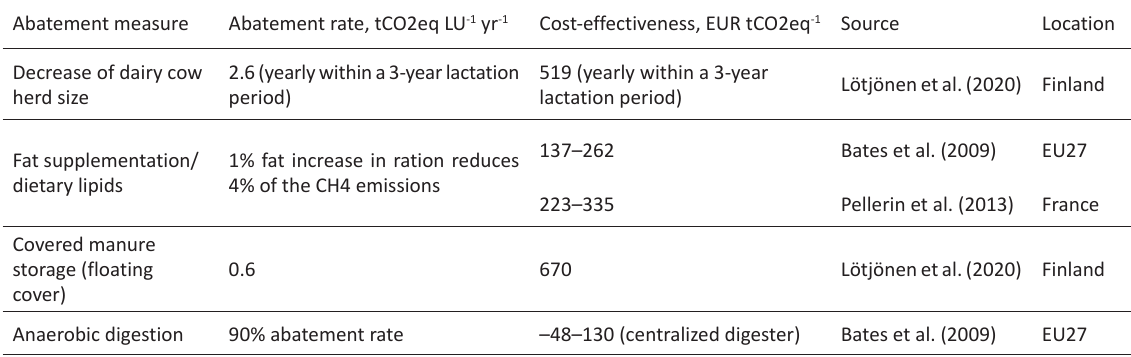
Table 2. Cost-effectiveness of measures related to dairy production